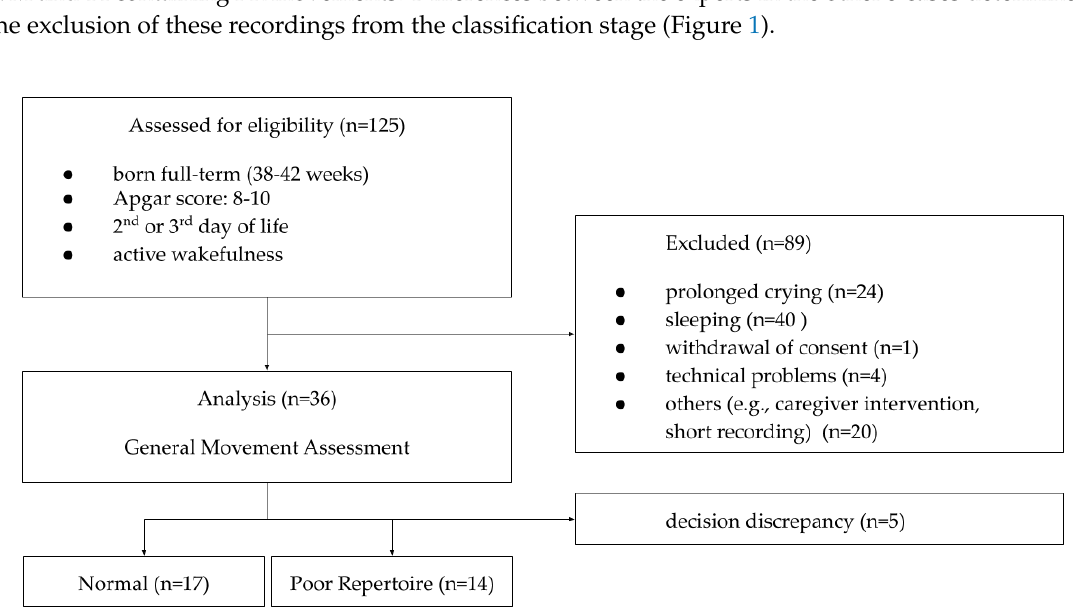
Figure 1. Flow diagram containing criteria for excluding recordings from further analysis and the division resulting from the application of